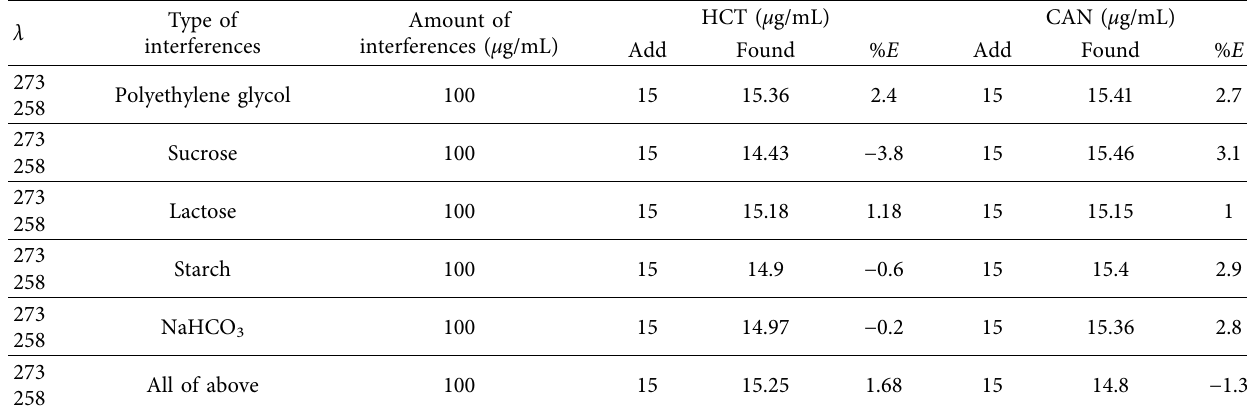
Table 14: Efect of interferences on the Q -absorption ratio method.